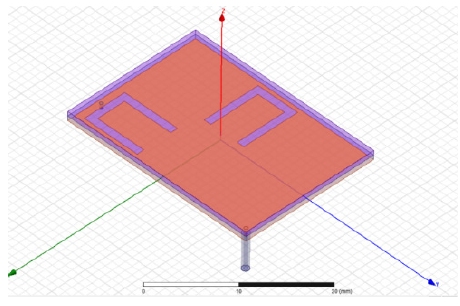
Figure 3. Design of the proposed antenna.